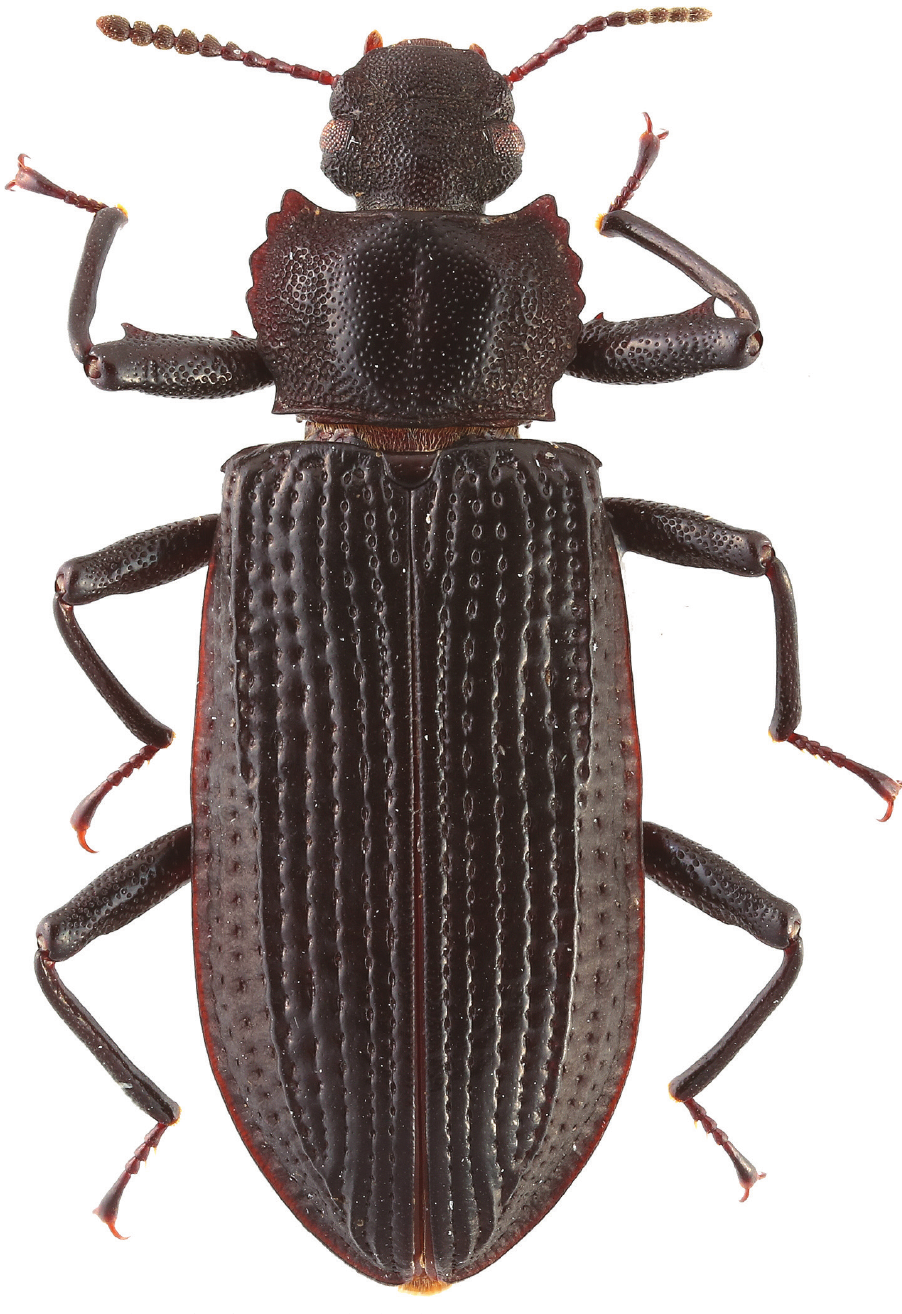
Figure 1. Habitus of C. bispinosus , male, dorsal